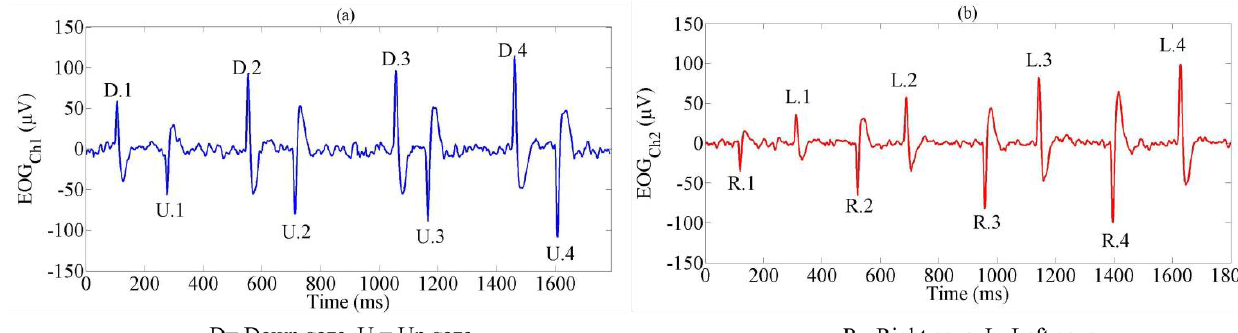
Figure 4. Four kind of gaze motion distances ( a ) EOG signal from Ch1 in vertical direction, and ( b ) EOG signal from Ch2 in horizontal